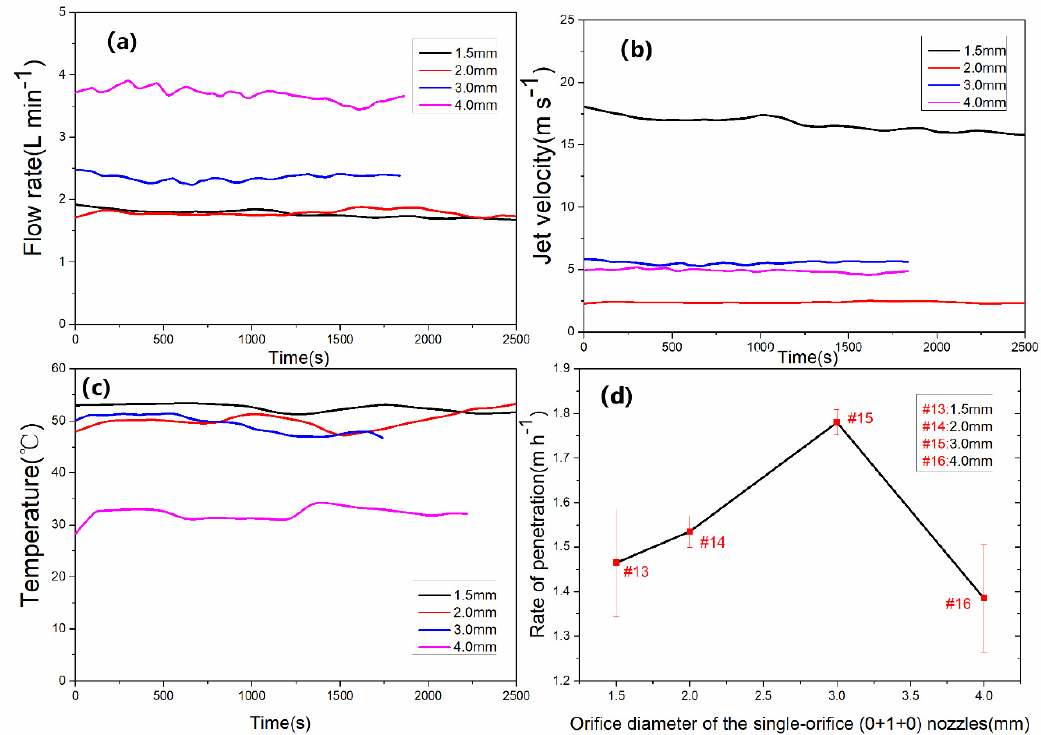
Figure 11. Graphs of drilling parameters of single-orifice nozzles with different orifice diameters: ( a ) flow rate vs. time; ( b ) jet velocity vs. time; ( c ) temperature vs. time; ( d ) rate of penetration vs. time.